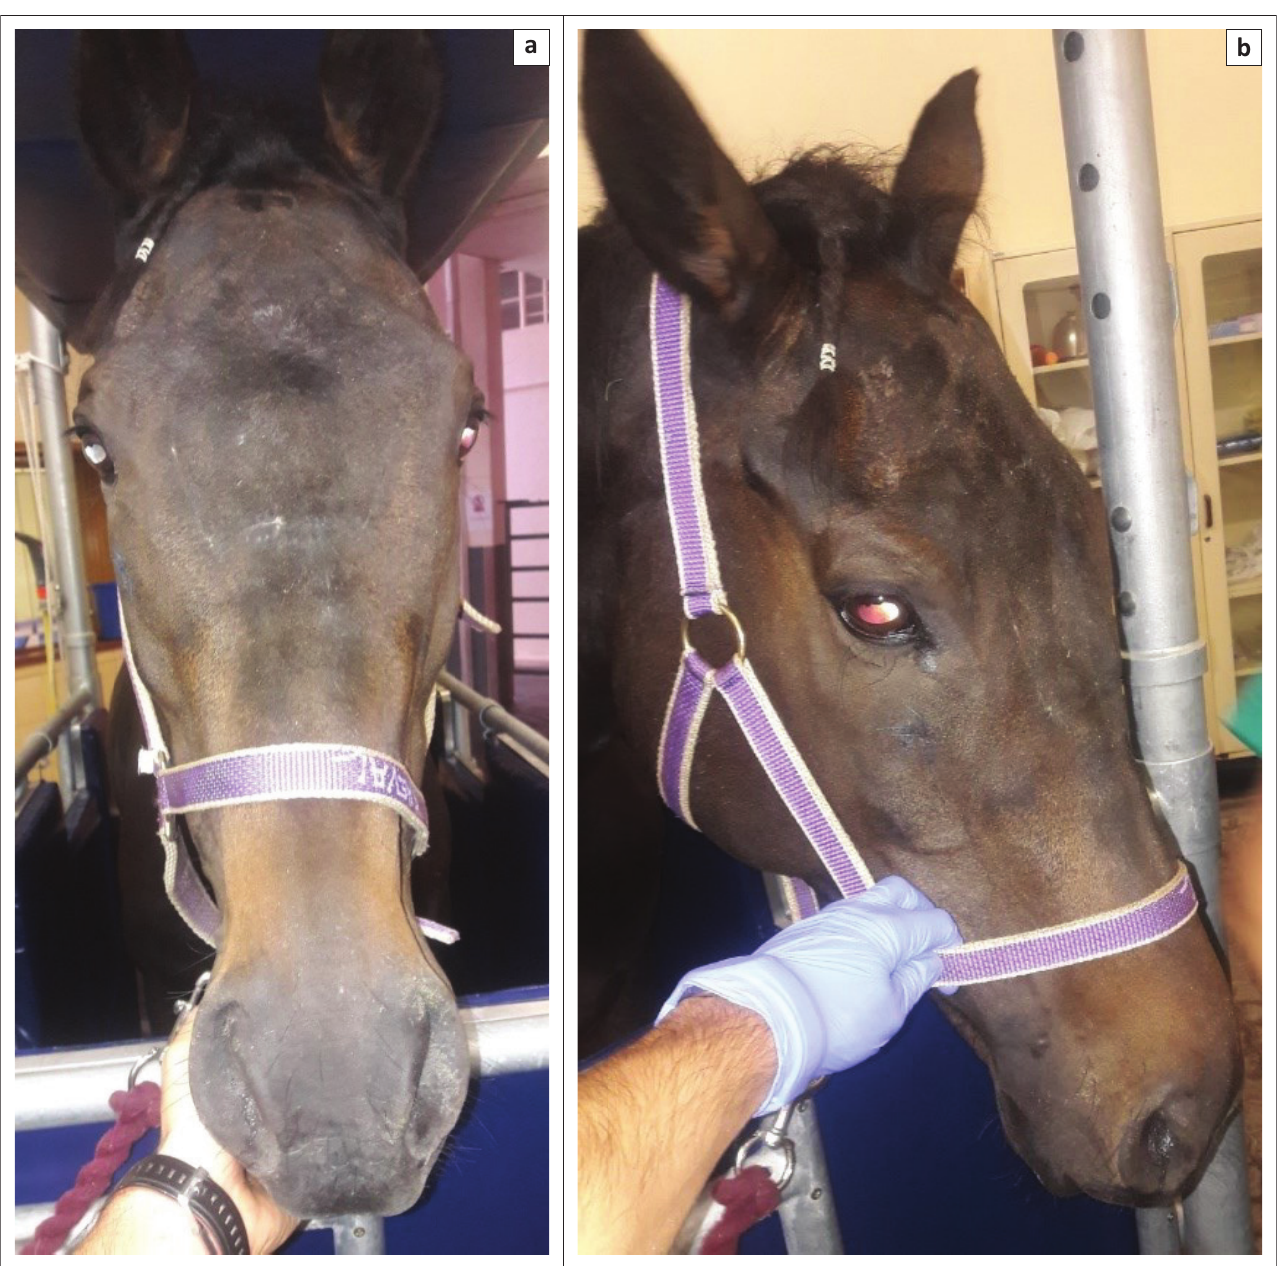
FIGURE 4: Photographs of the horse’s face 4 weeks after a large bilateral frontonasal bone flap was performed (a, b). Note the excellent cosmetic